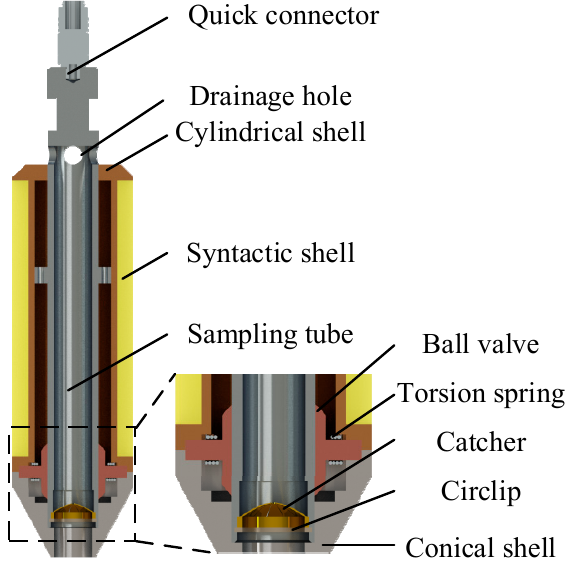
Figure 3. The sampling structure.